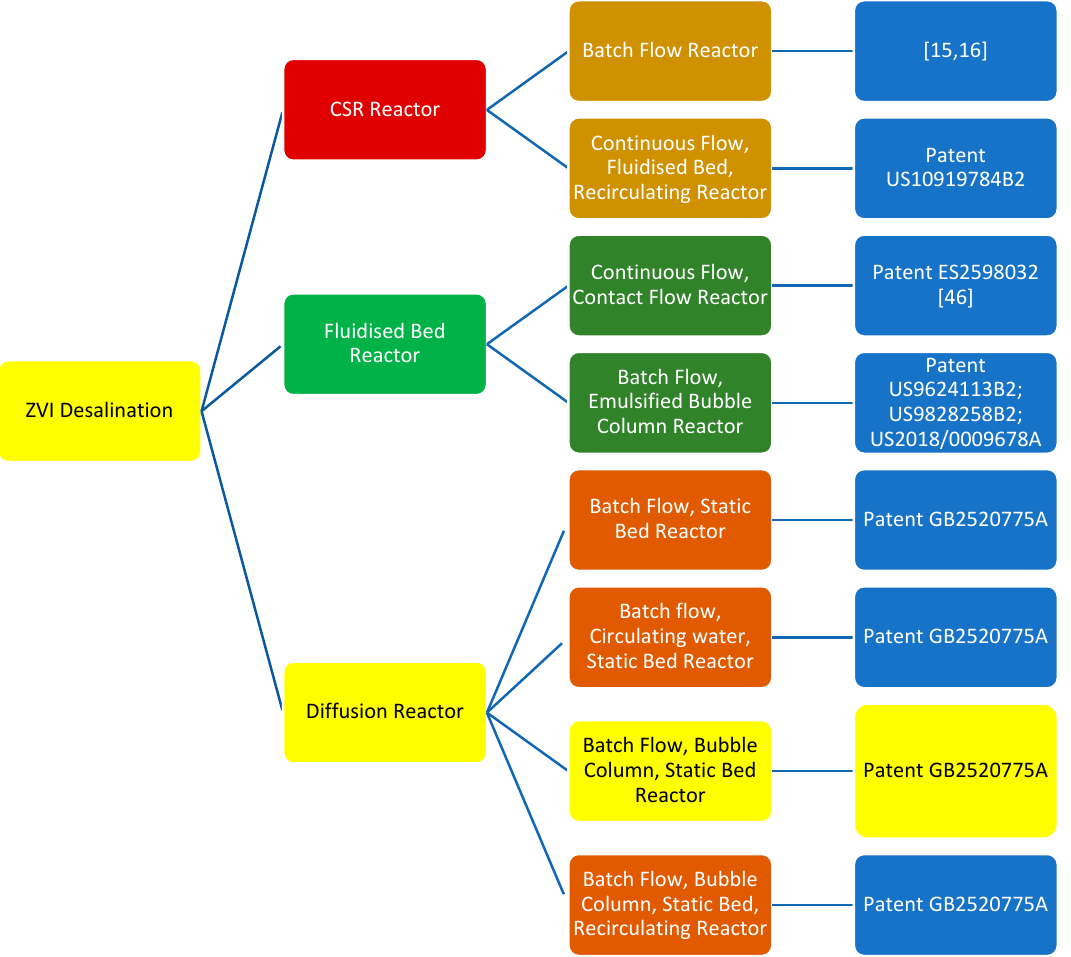
Figure A3. Reactors used to demonstrate ZVI desalination and associated patents and publications.